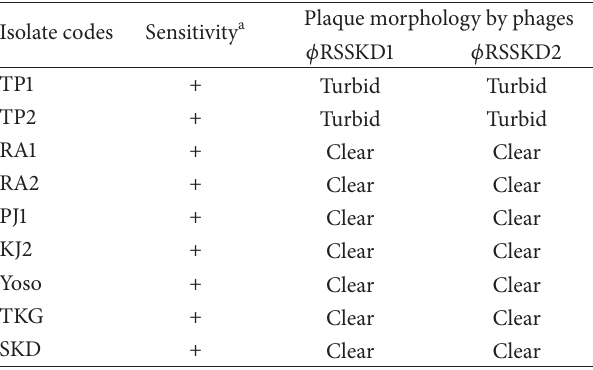
Table 2: Host range of bacteriophage against R. solanacearum and its plaque